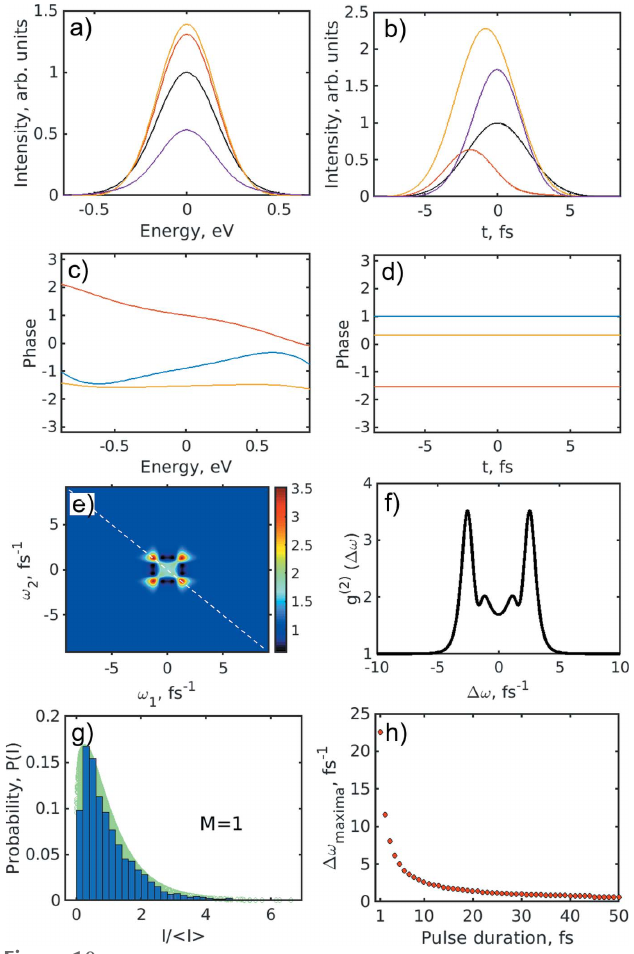
Figure 10 Spectral simulations for the seeded beam. ( a – d ) Example of generated single pulses in ( a ) the energy domain with bandwidth 0.4 eVand ( b ) the time domain with pulse duration T = 5 fs (FWHM). ( c , d ) The corresponding phases for these pulses in the energy domain ( c ) and in the time domain ( d ). The phases in the time domain were put to a constant value corresponding to phase at T = 0. ( e ) Second-order intensity correlation function g (2) ( ! 1 , ! 2 ) of the simulated spectra of the seeded beam. ( f ) Second-order intensity correlation function g (2) ( (cid:2) ! ) (black curve) taken along the white dashed line in ( e ). ( g ) Histogram of intensities of single pulses obeying the gamma function distribution (green background) with number of modes M = 1. ( h ) Distance between two maxima (cid:2) ! maxima in the g (2) ( (cid:2) ! ) correlation function in ( f ) as a function of pulse